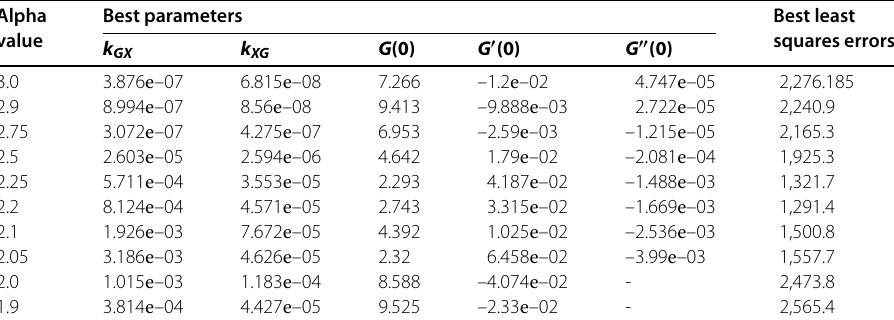
Table 4 Best least squares fits for fractional alpha model for subject 4 CGM data